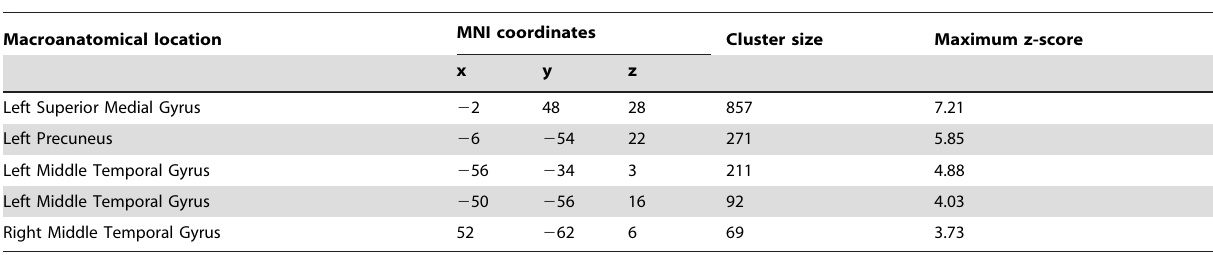
Table 4. Activation peaks of conjunction analysis of SOC > EMO.